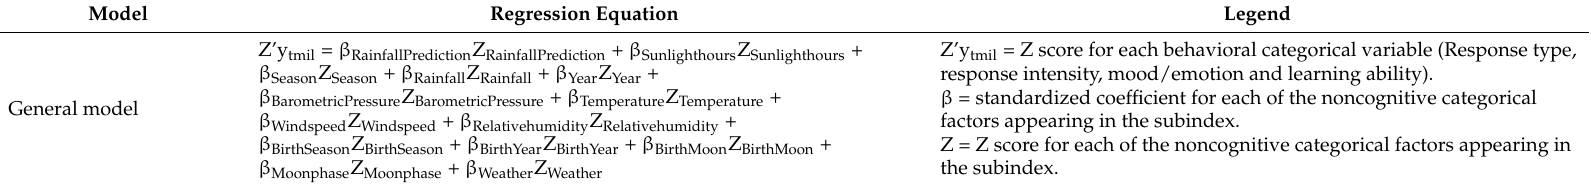
Table 8. Regression equations for the behavioral variables